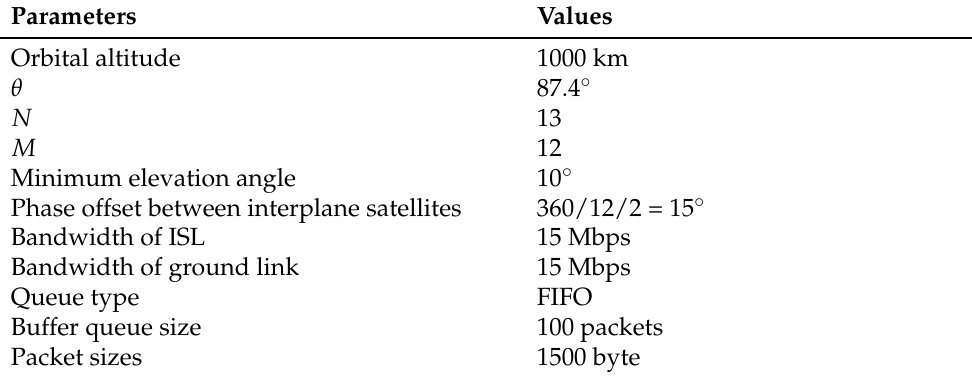
Figure 6. Simulation topology in a time interval. Table 4. Simulation